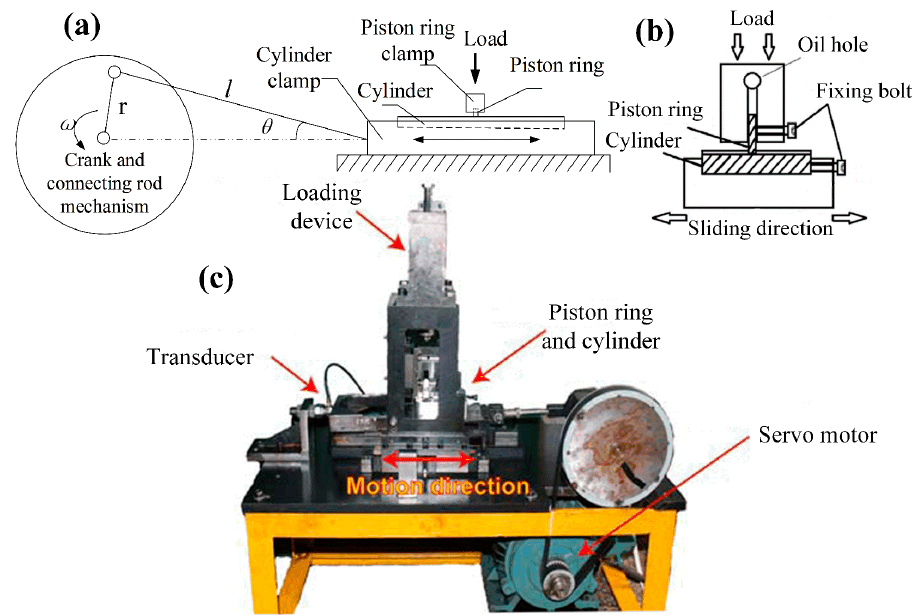
Figure 2. The schematic diagram and picture of the friction and wear tester. ( a ) the schematic of the friction and wear tester; ( b ) the schematic of the assembling jig; ( c ) the picture of the friction and wear tester.